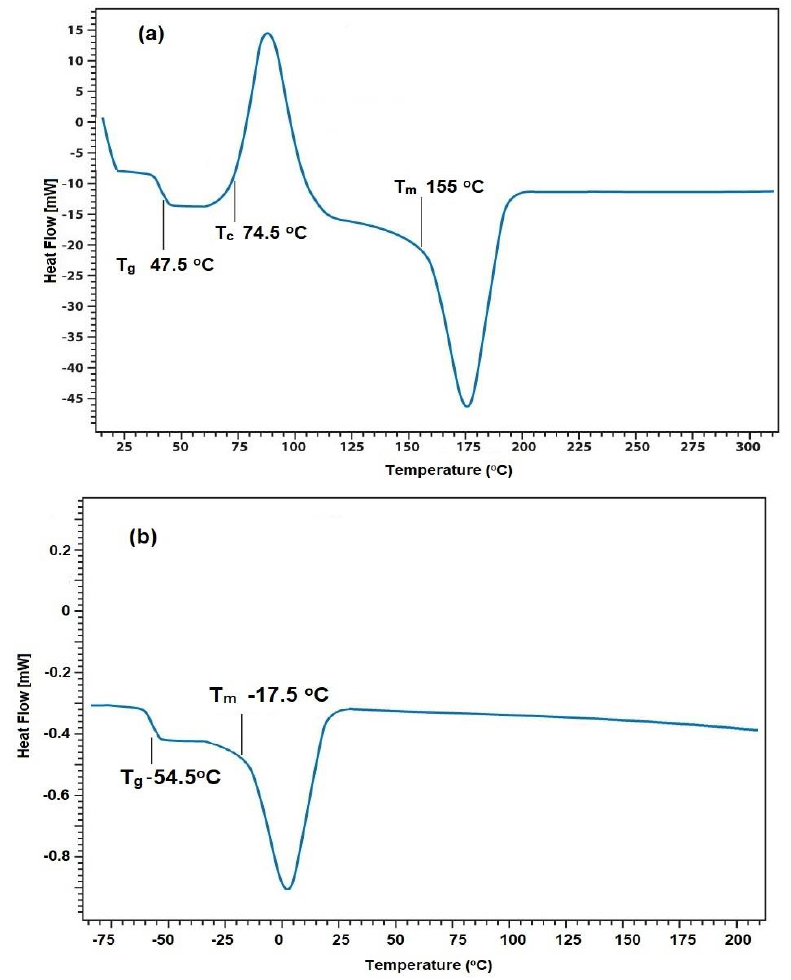
Figure 5. DSC thermograms of ( a ) APA and ( b ) PAIIL.